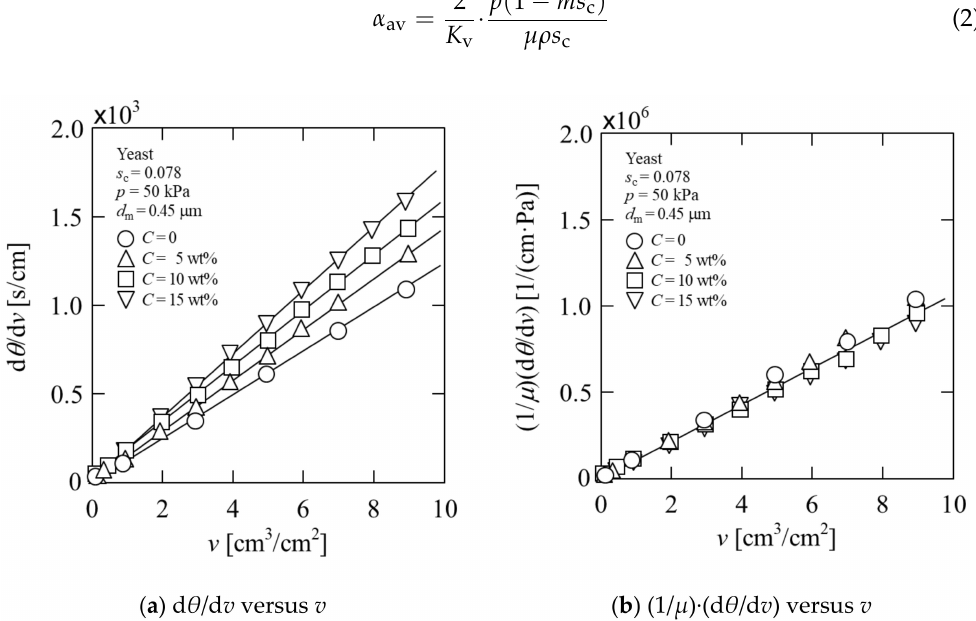
Figure 2. Microfiltration behavior of yeast suspension ( C = 0–15 wt%): ( a ) d θ /d v versus v ; ( b ) (1/ µ ) · (d θ /d v ) versus v